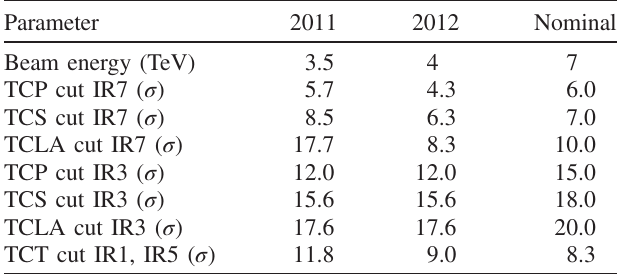
ffiffiffiffi p E .